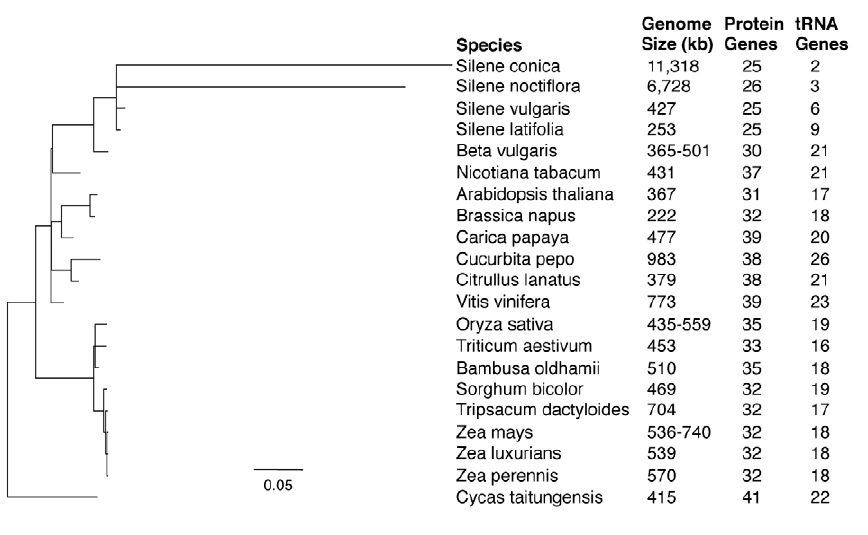
Figure 1. Sequence divergence, genome size, and gene content in seed plant mitochondria. Branch lengths are scaled to the number of synonymous nucleotide substitution per site ( d S ) on the basis of an analysis of all shared protein genes. Genome size ranges are reported for species with multiple sequences available. Gene counts exclude duplicates and putative pseudogenes.